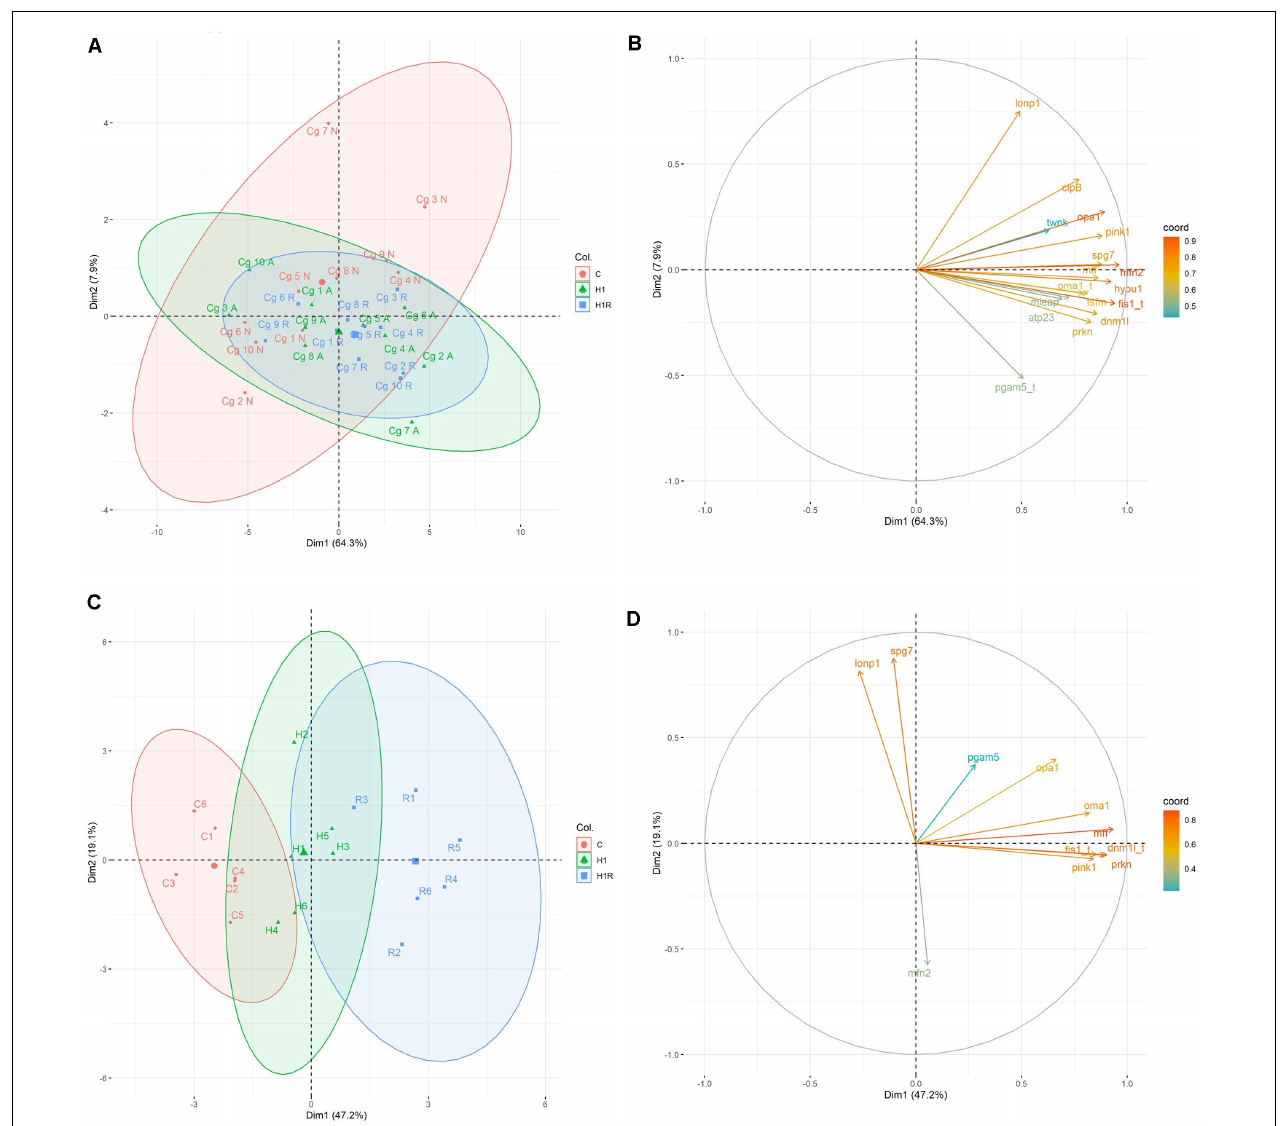
FIGURE 6 | PCA score plots and variable loading plots based on the studied biomarkers from M. edulis and C. gigas during H/R stress. (A,B) C. gigas ; (C,D) M. edulis ; (A,C) PCA score plot, position of the individual measurements from different experimental group within a coordinate system of first and second principal component. Horizontal axis depicts PC1 and vertical axis PC2. Colored ellipse includes all samples within 95% confidence interval. (B,D) Variable loading plot, visualization of weight distribution of different biomarkers on first and second principal component based on correlations between variables and dimensions. Close vectors define positive correlation between corresponding biomarkers. Coloring of vectors visualize coordinates. Horizontal axis depicts PC1 and vertical axis PC2. Gene name with appended “t” depicts transformed data to ensure normal distribution. Experimental groups: C, control, red; H1, short-term (1 day) severe hypoxia, green; H1R, short-term (1 day) severe hypoxia and subsequent 1.5 h reoxygenation, blue. Gene abbreviations: mfn 2, mitofusin 2; opa 1, mitochondrial dynamin-like 120 kDa protein; dnm 1 l , dynamin-1-like protein; mff , mitochondrial fission factor; fis 1, mitochondrial fission protein; tsfm , mitochondrial translation elongation factor Ts; lonp 1, mitochondrial Lon protease; spg 7, paraplegin; oma 1, mitochondrial metalloendopeptidase OMA1; clpB , mitochondrial caseinolytic matrix peptidase chaperone subunit B protein homolog; mieap , mitochondrial eating protein; atp 23, mitochondrial inner membrane protease ATP23; hyou 1, hypoxia upregulated protein 1; twnk , mitochondrial twinkle mtDNA helicase; prkn , E3 ubiquitin-protein ligase parkin; pink 1, PTEN-induced kinase 1; pgam 5, mitochondrial serine/threonine protein phosphatase PGAM5; β Act , beta Actin